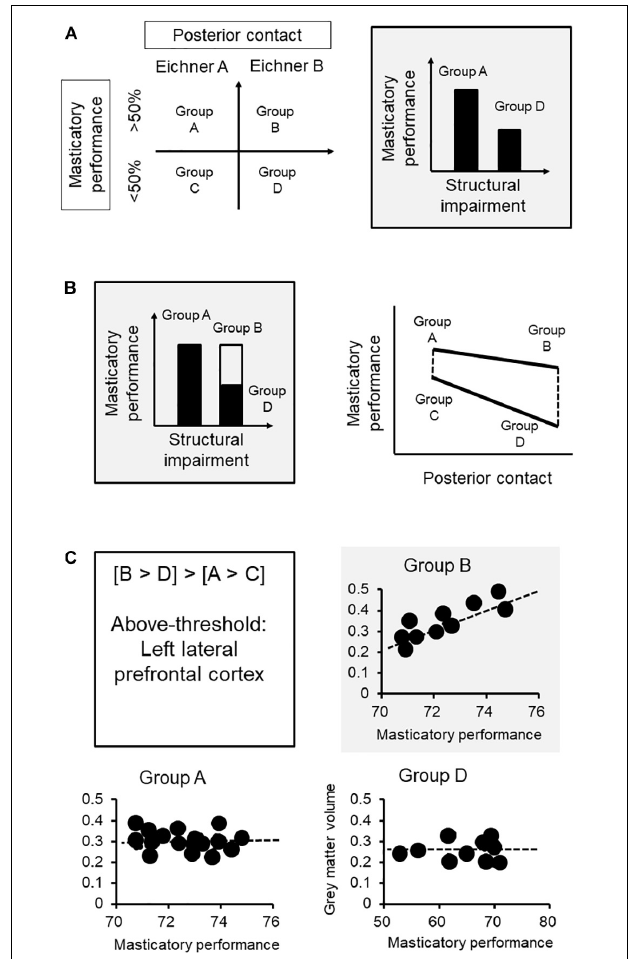
FIGURE 2 | Brain mechanisms of functional adaptation of mastication: an example of neuroimaging research. (A) We first clarify the association between functional performance and challenges. The sample was subgrouped by the degree of structural impairment based on the Eichner class, which reflects the degree of posterior contact, and the functional aspect according to masticatory performance. (B) Each group was further subgrouped by masticatory performance via median split. Based on the subgrouping, subgroup B represents the subjects who had less teeth contact but maintained a good masticatory performance (i.e., the adapted group) that showed no statistically significant difference from subgroup A. Subgroup D, which represents the subjects who did not adapt to the loss of posterior contact, would showed a significantly lower masticatory performance, compared to either subgroup A or B. The interactional effect ([B vs. D] vs. [A vs. C]) revealed changes in functional performance specifically in the subgroup with worse structural impairment. (C) The lateral prefrontal cortex showed such an association specifically to the adaptive subgroup (i.e., subgroup B) but not in the non-adaptive group (i.e., subgroup D) or the other subgroups. The findings strengthen the role that an increased gray matter volume at the prefrontal cortex, which may imply a better individual brain reserve in cognitive processing and learning, would contribute to better adaptation in masticatory performance. ∗ The functional performance of the adaptive